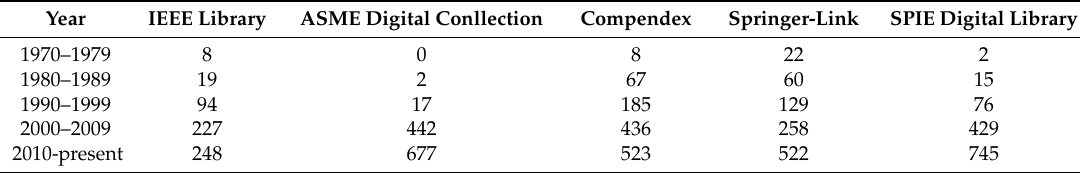
Table 2. Count of published papers about cutting force sensors from 1970.